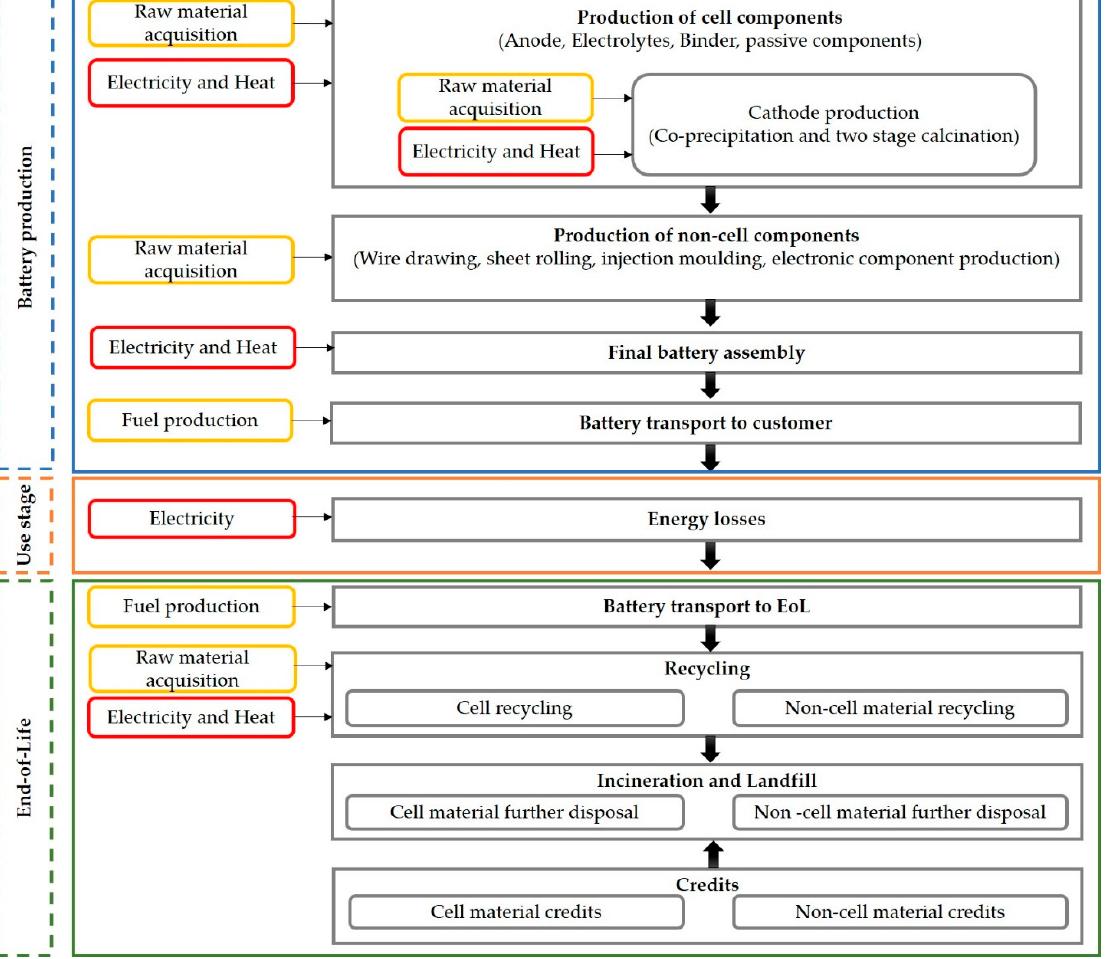
Figure 1. System boundaries of the LCA of the battery (adapted from PEFCR).